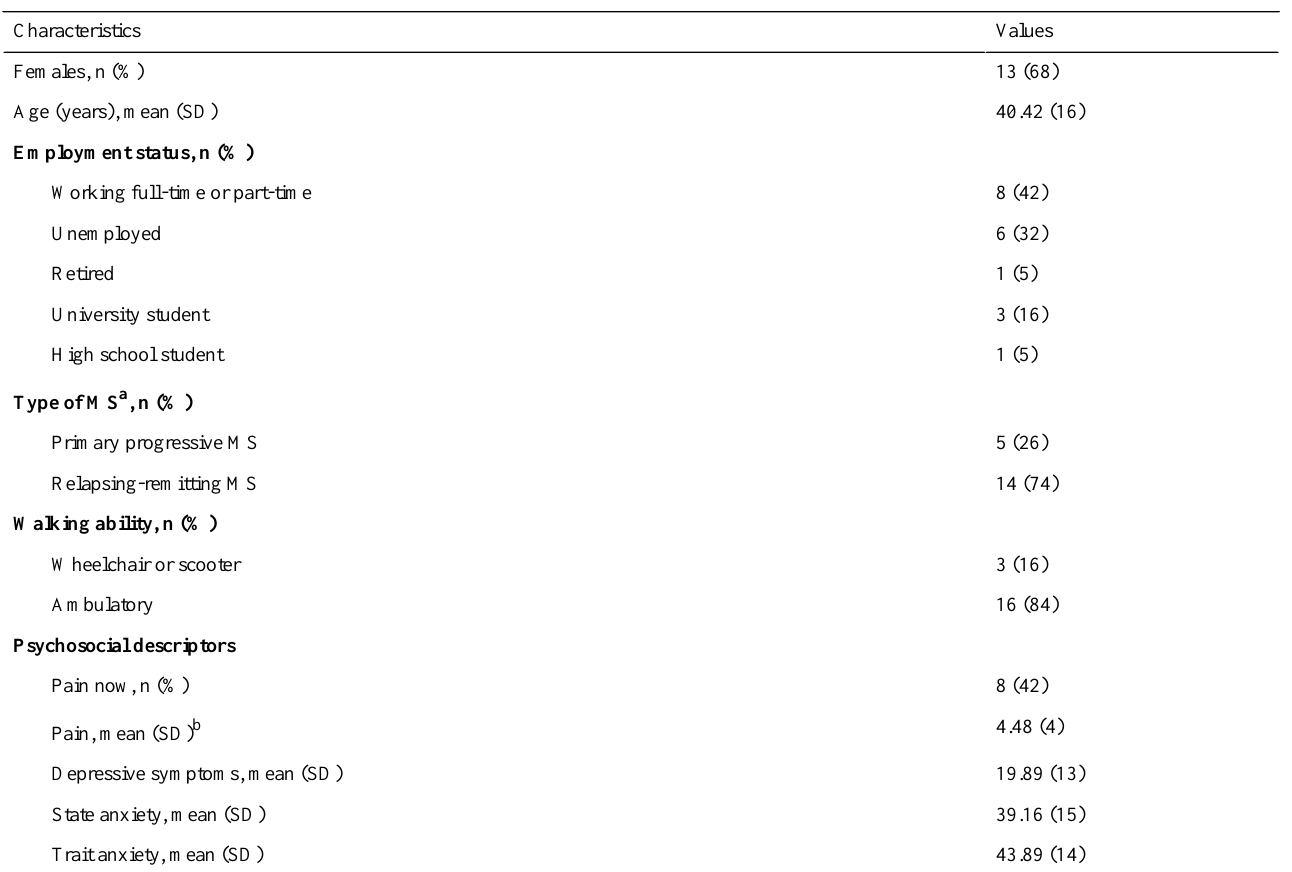
Table 2. Participant demographics (N=19).